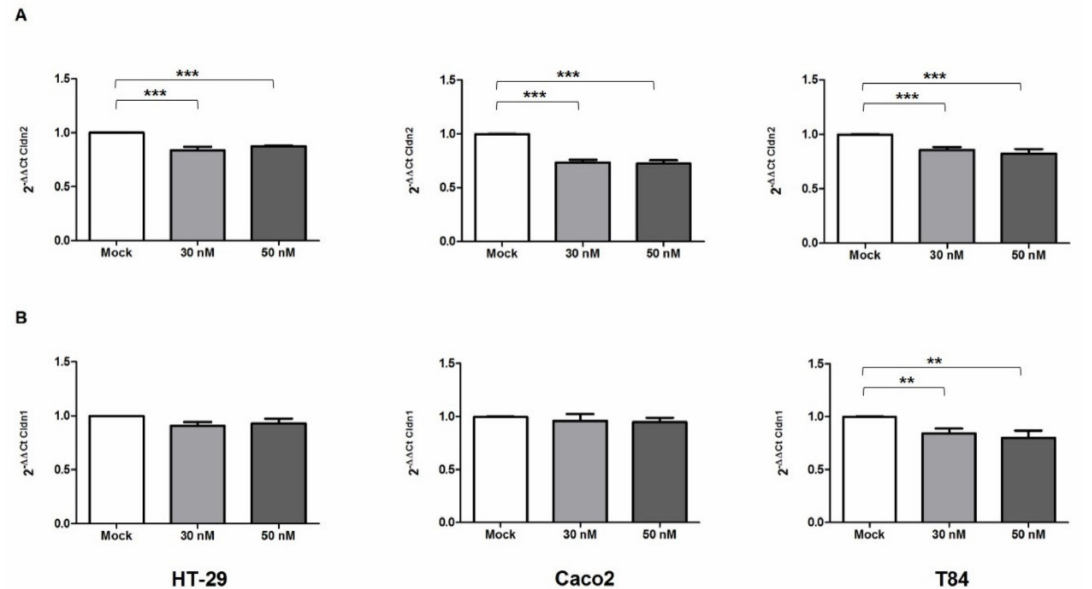
Figure 1. Cldn2 and Cldn1 mRNA expression after miR-195-5p mimic transfection and TNF- α stimulation. ( A ) Cldn2 mRNA expression was analyzed by Real-Time PCR after transfection with miR-195-5p mimic in TNF- α -stimulated HT-29, Caco2 and T84 human cell lines. The increase of intracellular amount of miR-195-5p (at 30 nM and 50 nM concentrations) led to a significant decrease of Cldn2 in all cell lines. ( B ) Cldn1 mRNA expression was analyzed by Real-Time PCR after transfection with miR-195-5p mimic in HT-29, Caco2 and T84 human cell lines. Cldn1 mRNA levels were slightly modulated after transfection but not in a significant manner except for T84 cell line. Mock indicates mock-transfected cells going through the transfection processes without addition of mimic miRNA. Expression data were normalized on the housekeeping gene Gapdh. Data are representative of four independent experiments (mean ± SEM). ** p < 0.001; *** p <